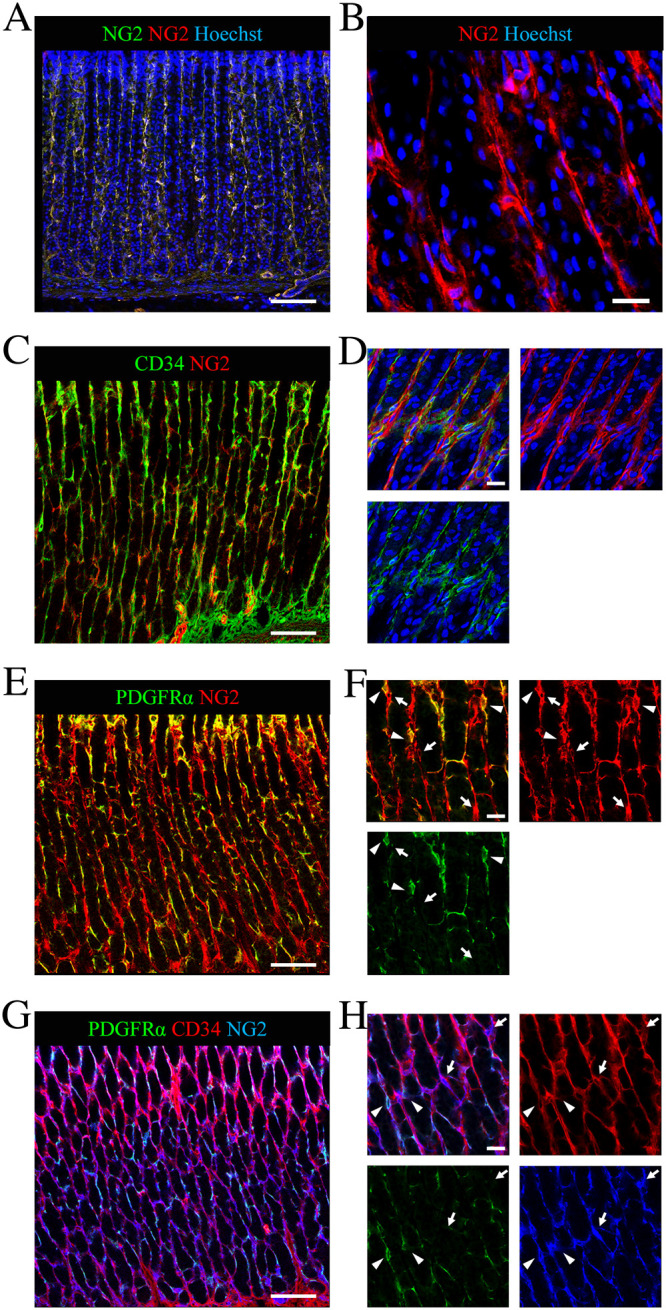
Localization and characterization of NG2 cells in the stomach of adult rats.(A-B) Localization of NG2 cells in the gastric mucosa. (A) Immunofluorescent images showing staining with both monoclonal NG2 (green) and polyclonal NG2 (red) antibodies and Hoechst (blue). (B) Magnified view of immunofluorescent images showing staining for NG2 (red) and Hoechst (blue). (C-D) Colocalization of CD34 (green) in NG2+ telocytes (red) of the adult stomach. Immunofluorescence staining for NG2 (red), Hoechst (blue) and CD34 (green) (a telocyte marker). (E-F) Co-expression of PDGFRα (green) in NG2+ telocytes (red) in the gastric mucosa. Immunofluorescence staining for NG2 (red) and PDGFRα (green) (another telocyte marker). Arrowheads show NG2+/PDGFRα+ telocytes whereas arrows point to NG2+/PDGFRα- telocytes. (G-H) Triple immunofluorescence staining for PDGFRα (green), CD34 (red) and NG2 (blue). Arrowheads indicate NG2+/CD34+/PDGFRα+ telocytes and arrows show NG2+/CD34+/PDGFRα- telocytes. Scale bars: 100 μm (A, C, E, G) and 20 μm (B, D, F, H).